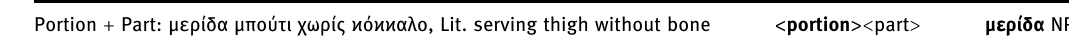
Table 9: The dish name is headed by “ portion ” plus a noun denoting < part > . No MI is supplied Noun phrases headed by Portion